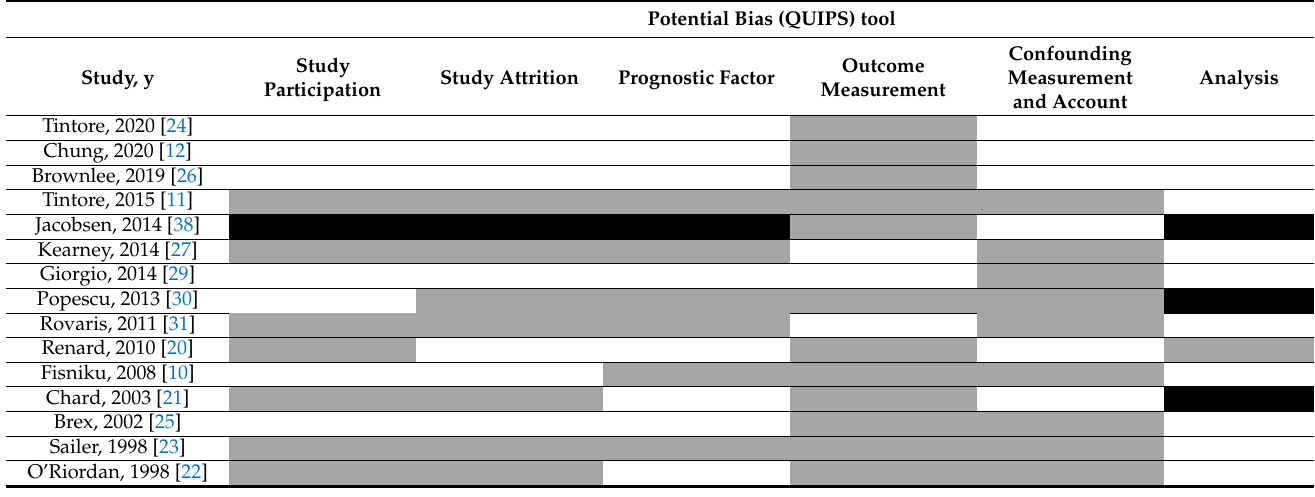
Table 1. Quality assessment and potential bias: No: